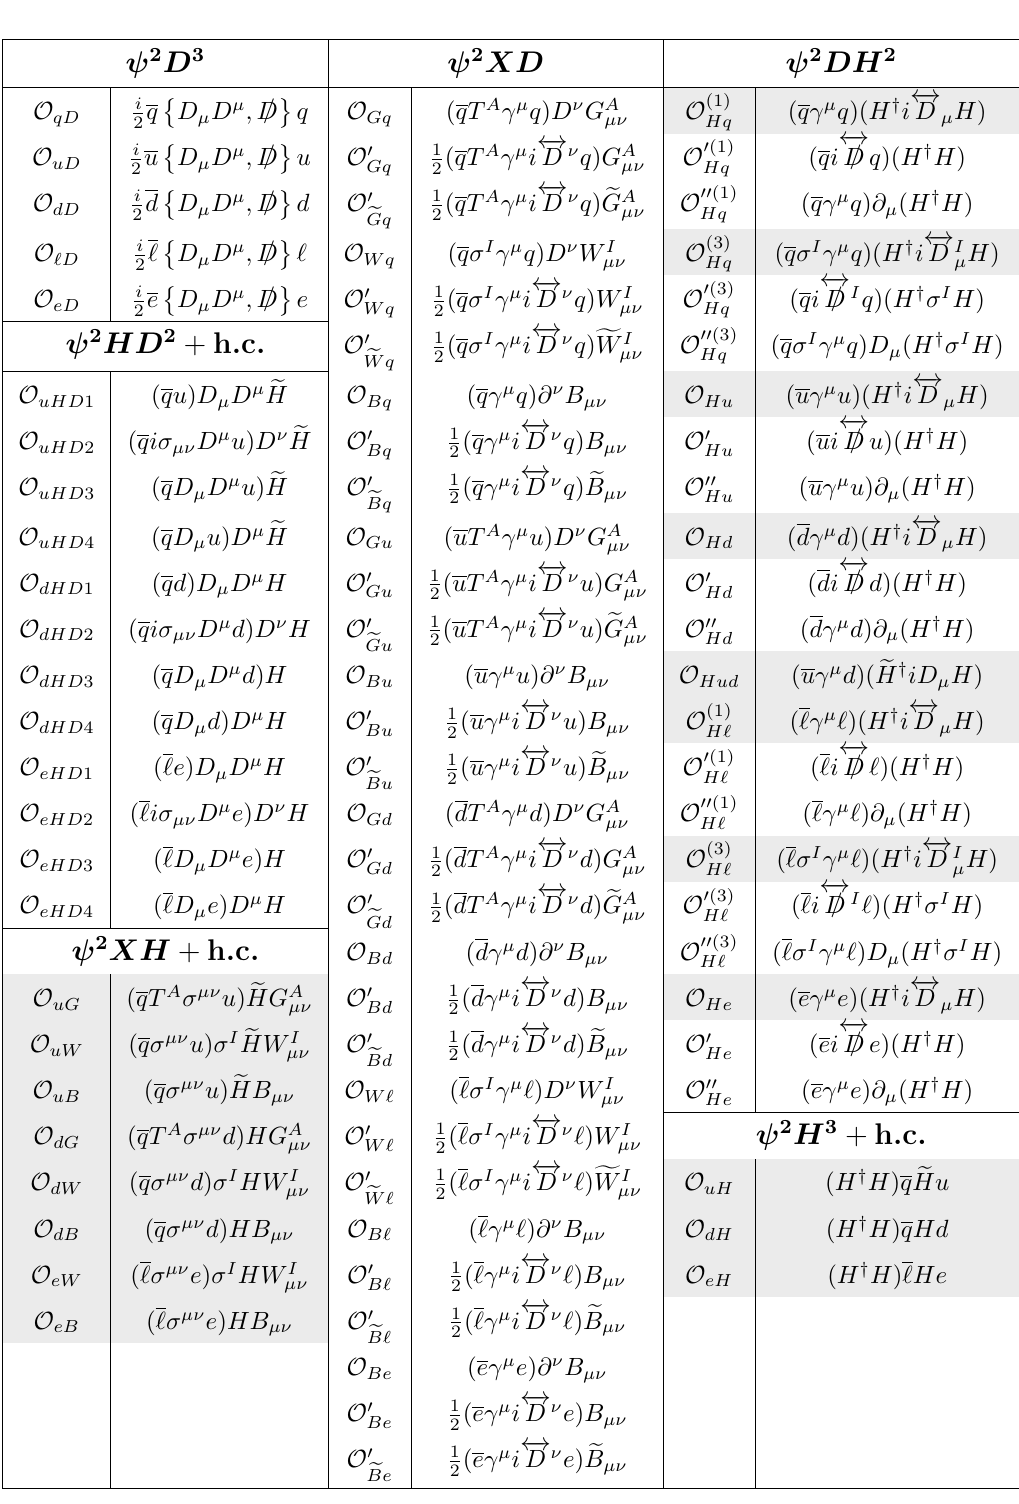
Table 8 . Two-fermion operators in the Green’s basis. Generation indices are